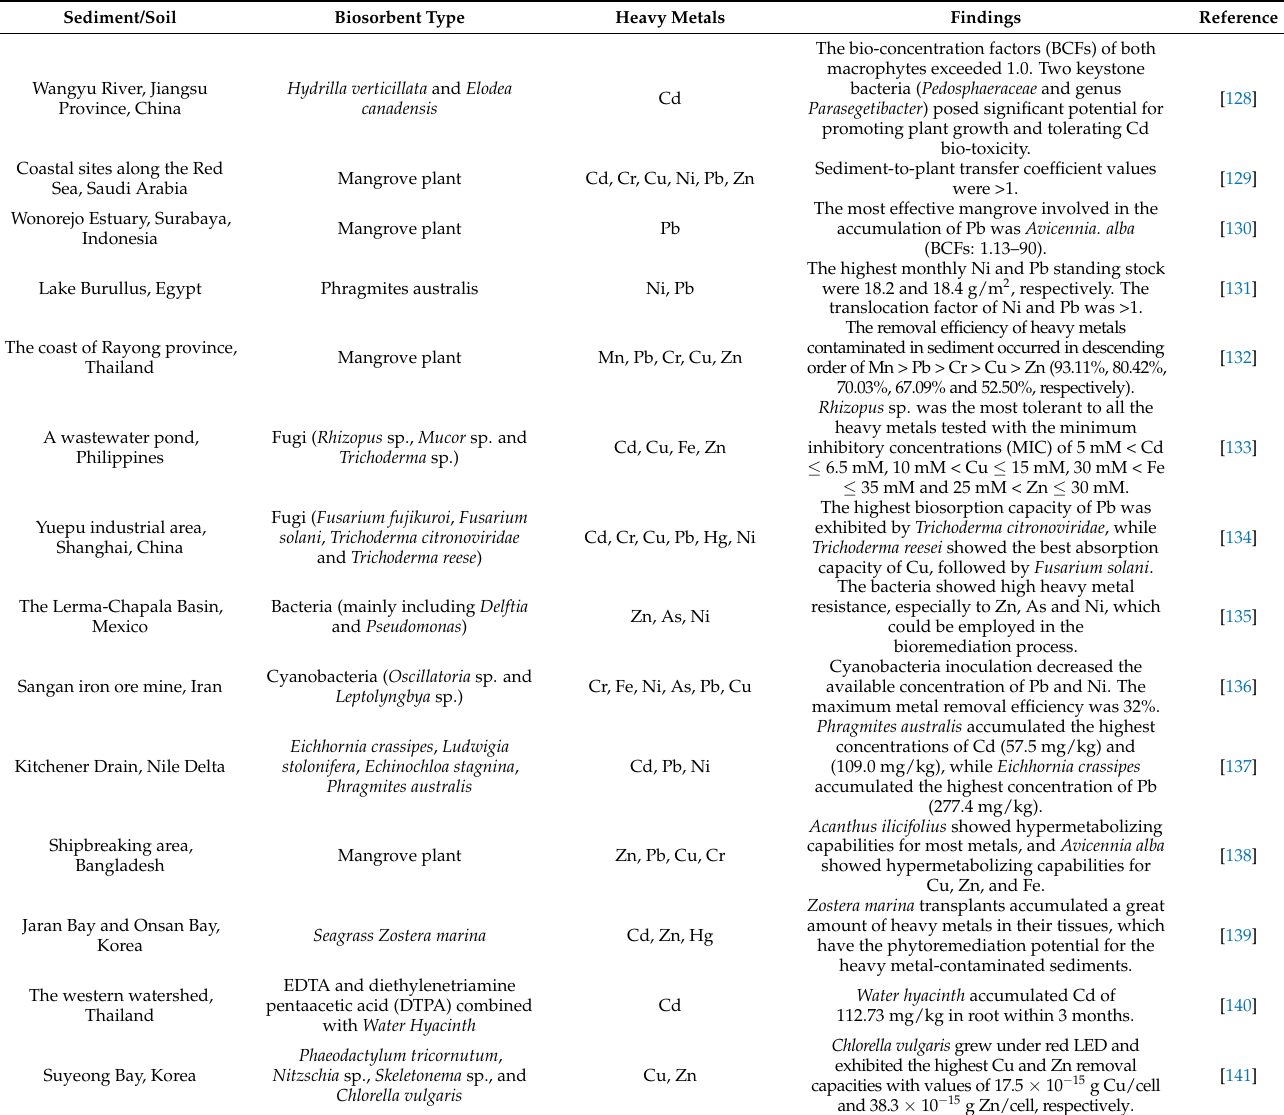
Table 2. Bioremediation for heavy metal contaminated sediment/soil in recent